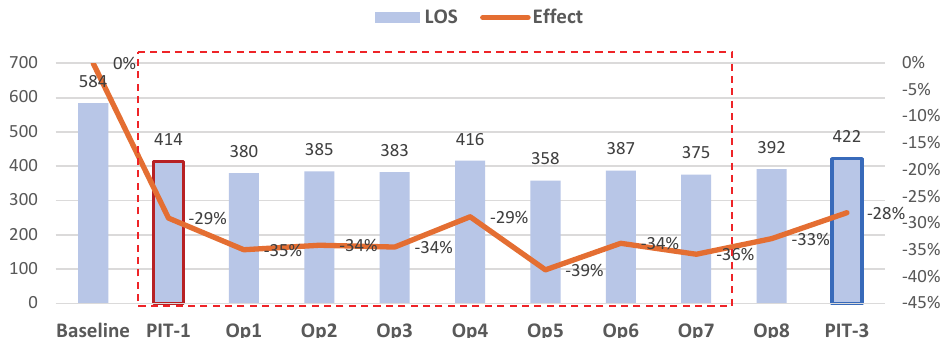
Fig. 10 . Effects of allocating a PIT during different hours of a day on patient average throughput time in comparison with the baseline measure (24hrs vs 8hrs in busy time vs non-busy